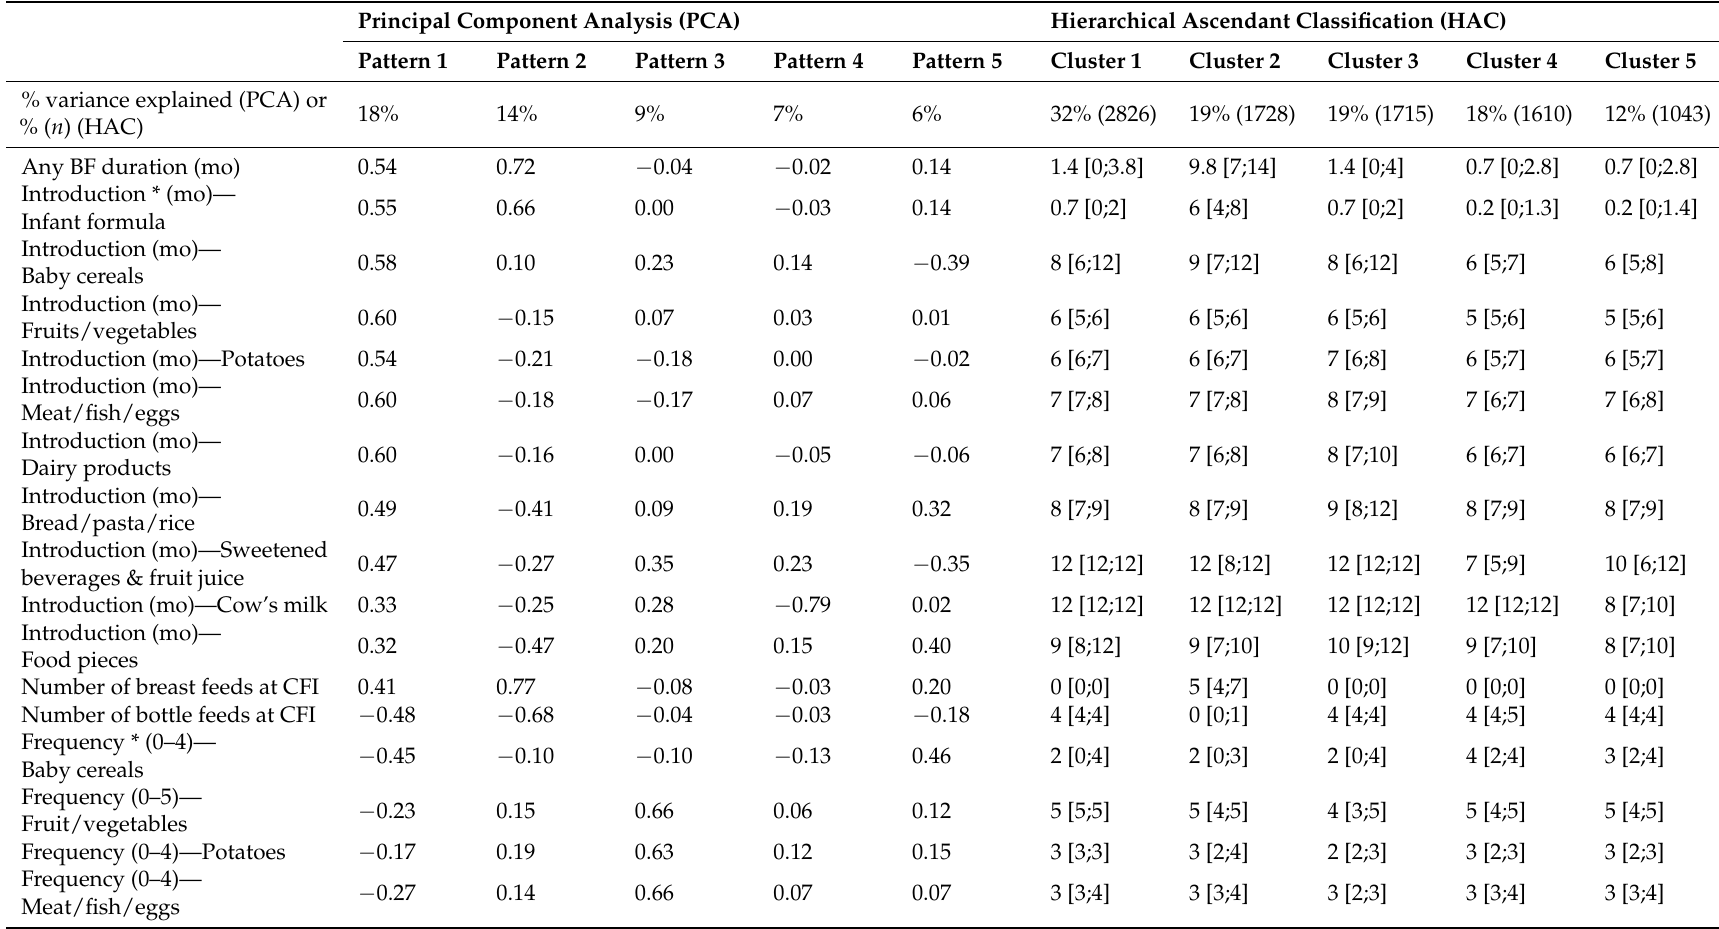
Table 3. Analysis of core variables (BF and main food groups), food pieces, organic and commercial complementary foods, Set C of variables ( n =